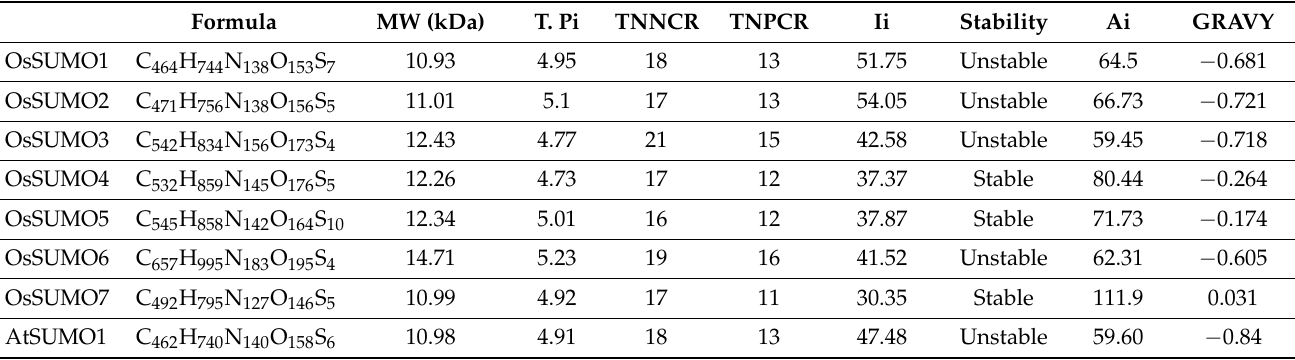
Table 2. Physiochemical Properties of OsSUMOs and AtSUMOs by